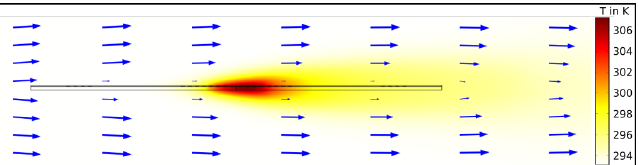
Figure 2. Result of the FEM simulation (for air as fluid) around the sensor. The colour indicates the temperature distribution for a heating power of 1W while the blue arrows indicate the flow velocity field at a mean flow velocity of